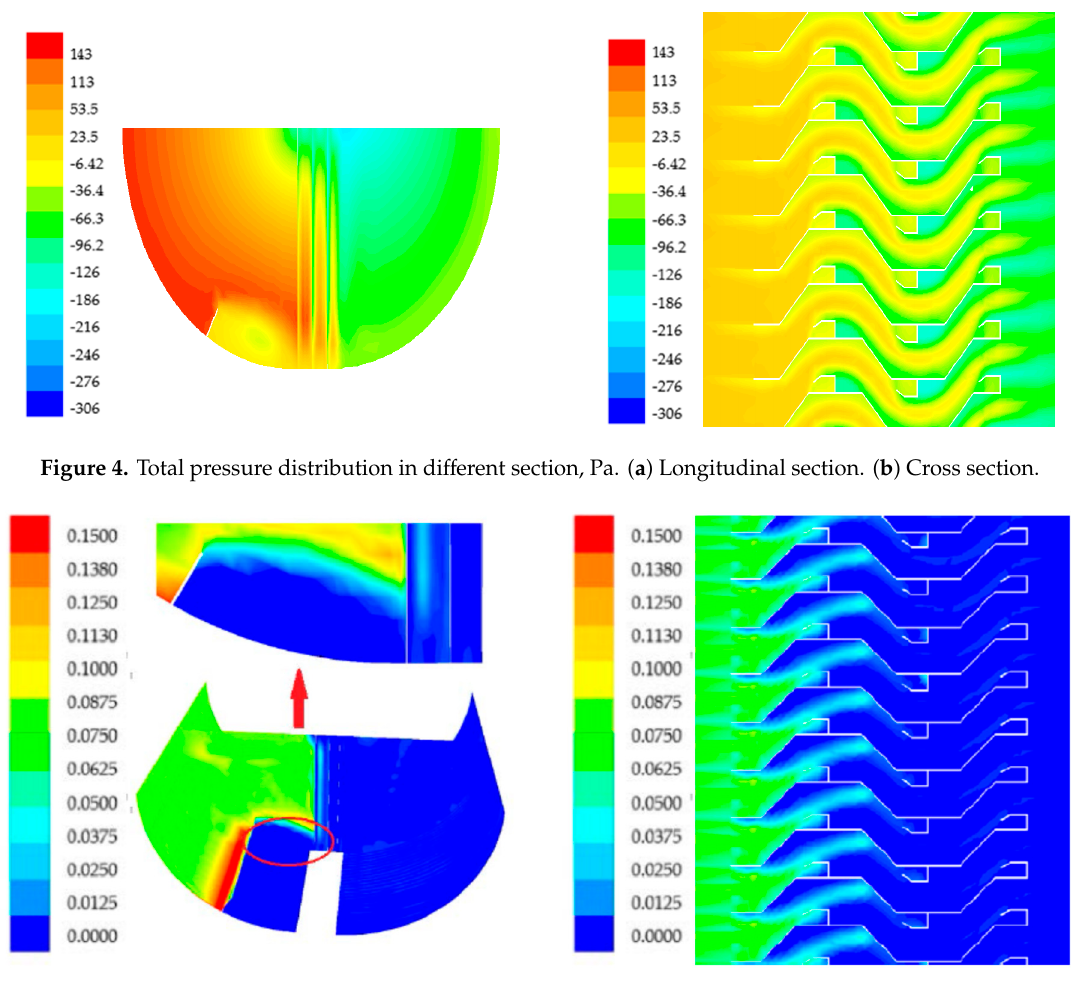
Figure 5. Droplets phase concentration distribution in different section. ( a ) Longitudinal section. ( b ) Cross Cross section.